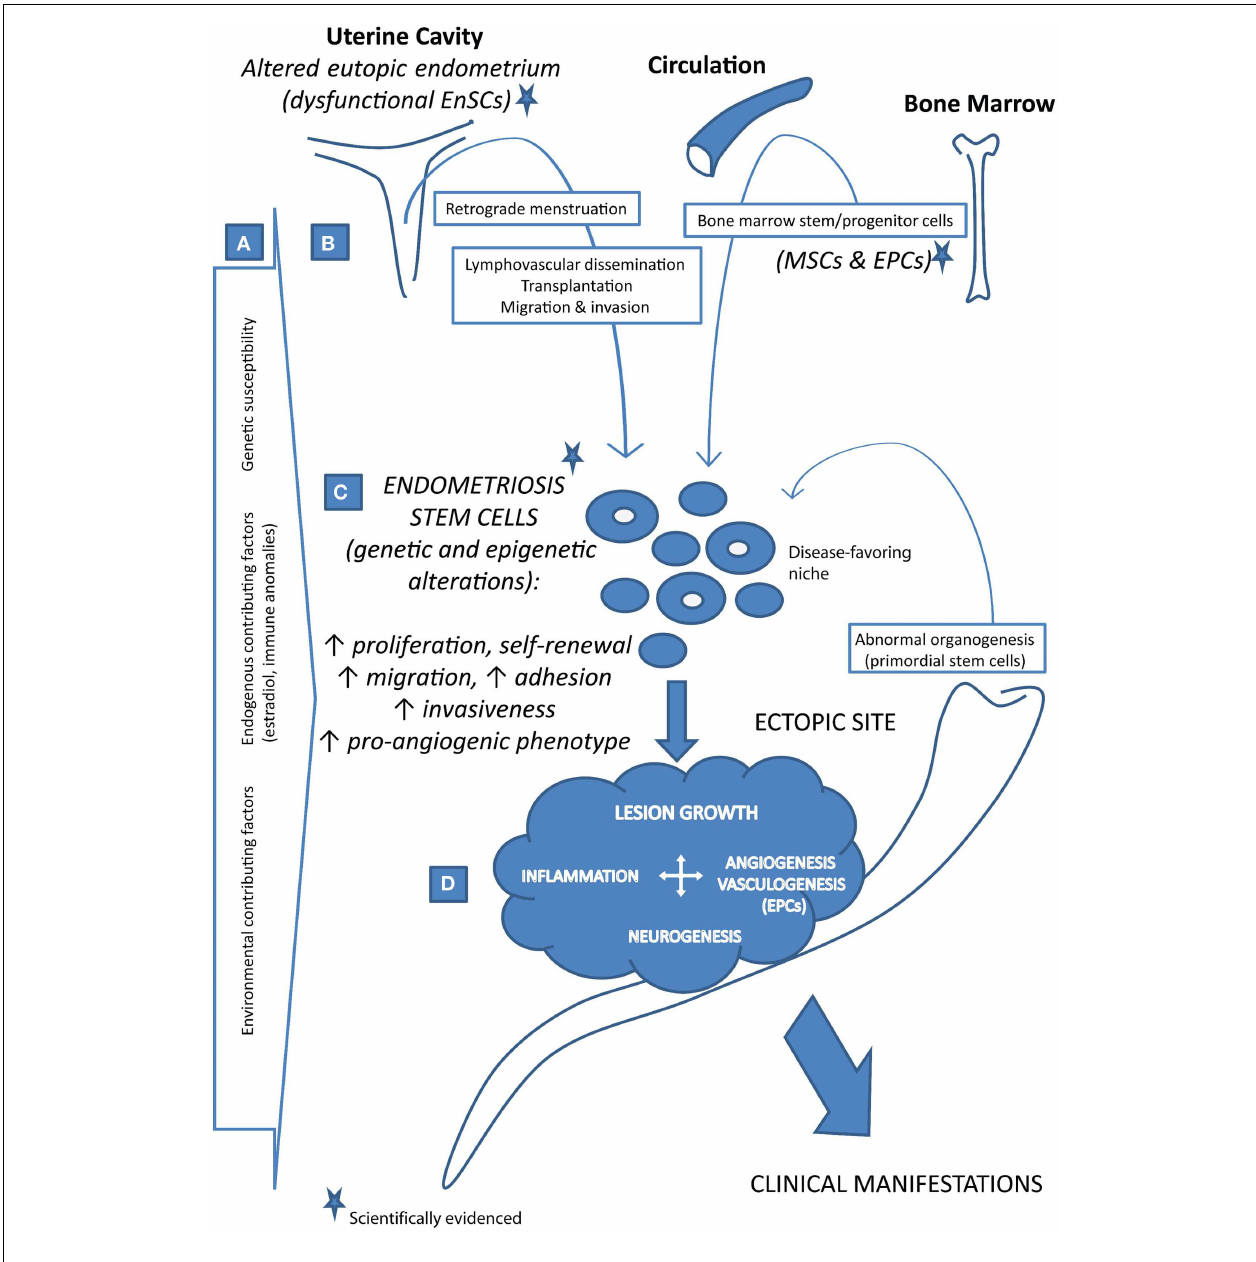
are altered in endometriosis patients), bone marrow may also contribute to the endometriosis stem cell pool with its stem/progenitor cells (bone marrow-derived mesenchymal stem cells, MSCs , and endothelial progenitor cells, EPCs ). (C) Endometriosis stem cells are dysfunctional due to a range of genetic and epigenetic alterations, displaying increased self-renewal, survival, and aggressive phenotype. (D) Upon the establishment, growing lesions require and induce angiogenesis as well as the vasculogenic blood vessel formation from EPCs.Together with inflammation and innervation, vascularized growth of endometriosis lesions results in the appearance of the disease clinical manifestations.